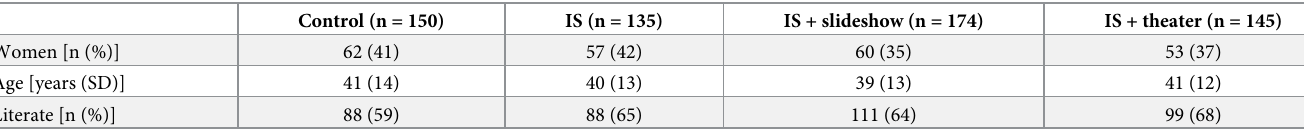
Table 1. Characteristics of interviewees stratified by